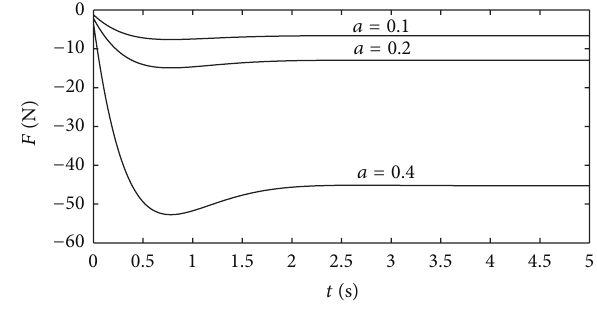
Figure 4: The influence of the acceleration on the dynamic tension ( 𝜉 = 0.8 , 𝛼 = 0.4 ): (a) 𝑎 = 0.1 m / s; (b) 𝑎 = 0.2 m / s; (c) 𝑎 = 0.4 m /